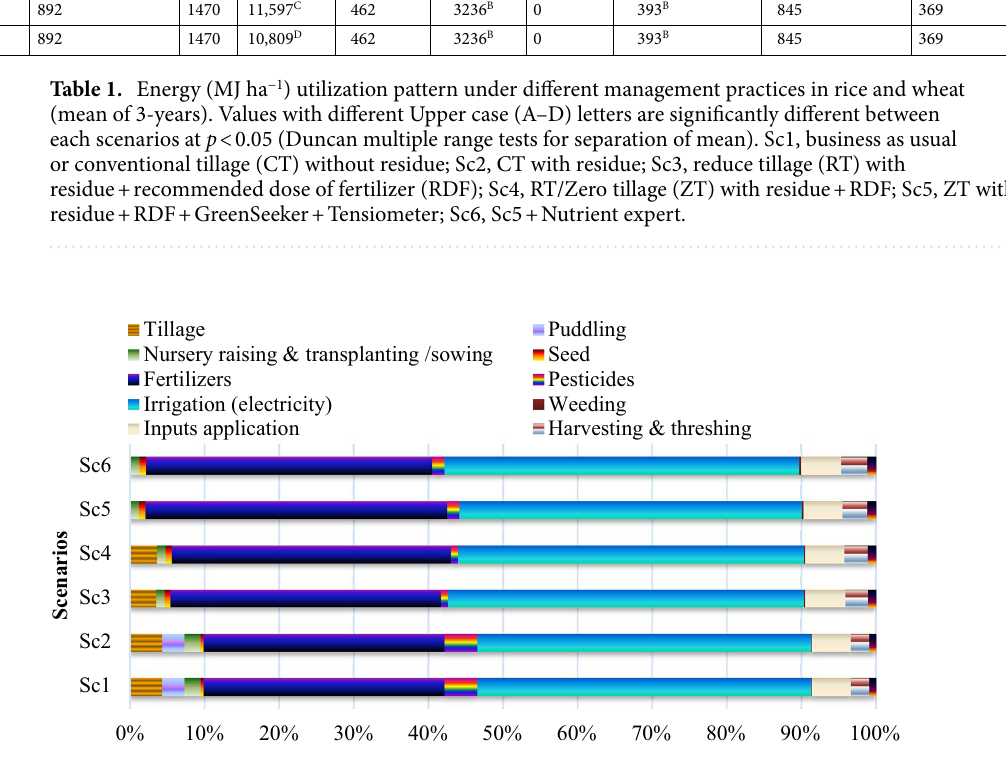
Figure 1. Operation-wise input energy-use pattern (%)under different management practices in rice. Where; Sc1, business as usual-conventional tillage (CT) without residue; Sc2, CT with residue; Sc3, reduce tillage (RT) with residue + recommended dose of fertilizer (RDF); Sc4, RT/Zero tillage (ZT) with residue + RDF; Sc5, ZT with residue + RDF + GreenSeeker + Tensiometer; Sc6, Sc5 + Nutrient